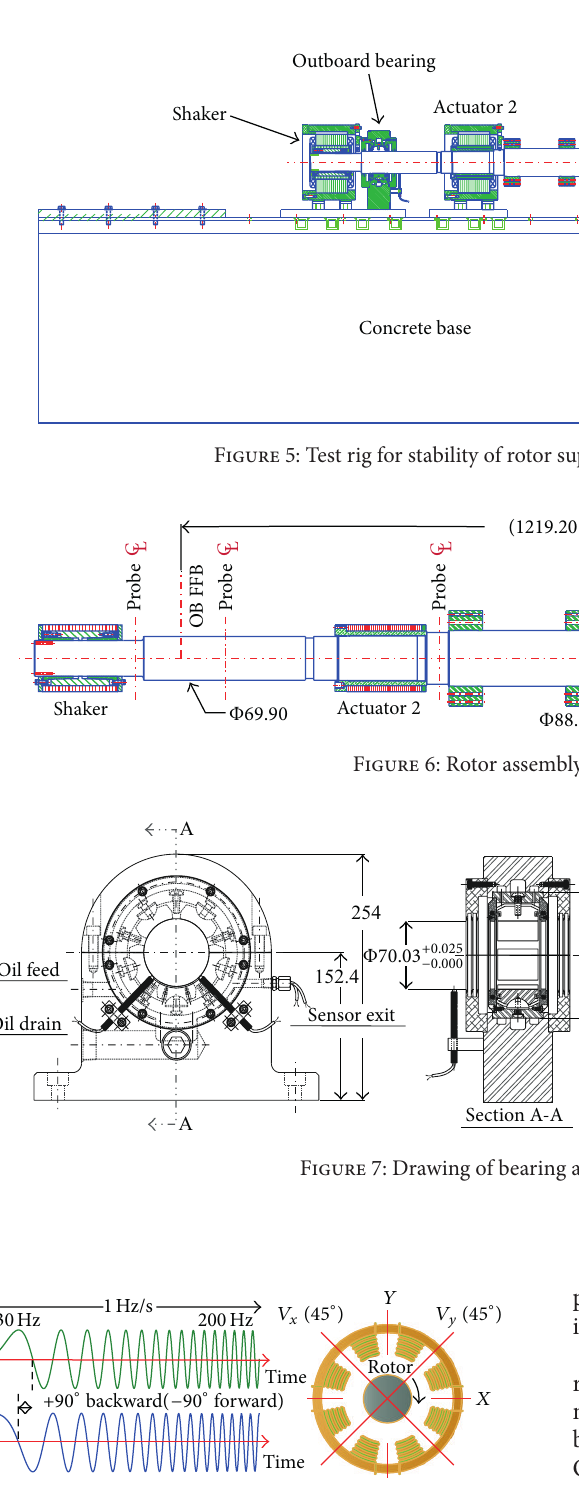
Figure 8: Current signal of the magnetic bearing exciter.